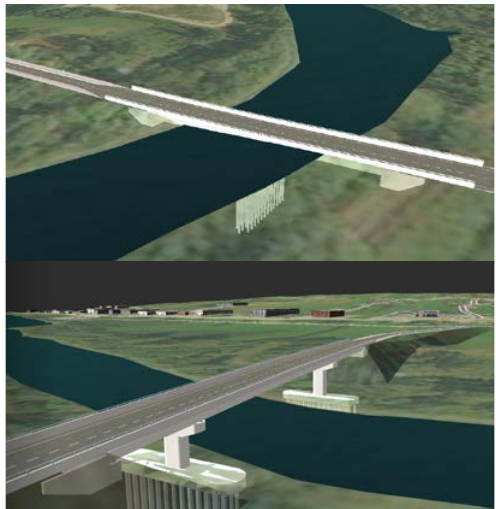
Figure 5. The bridge in the first step of parametric modelling (top) and the final solution after some manual corrections